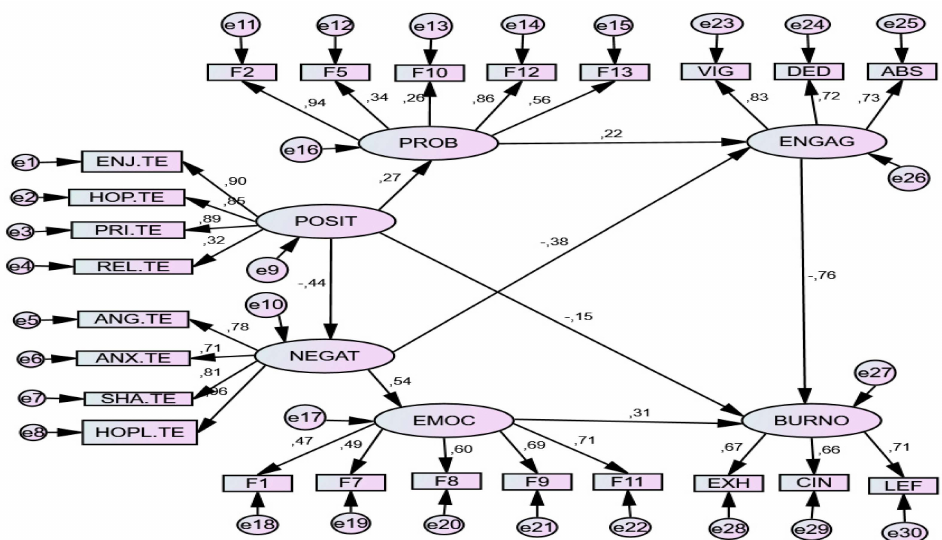
Figure 4. SEM model for Test Situation (Stress level 3) . Note . POSIT = Positive Achievement Emotions (Enjoyment, Hope, Pride); NEGAT = Negative Achievement Emotions (Anger, Anxiety, Shame, Hopelessness, Boredom); PROB. Problem-focused strategies : F2. Seeking help and family advice; F5. Self-Instructions; F10. Positive reappraisal and firmness; F12. Comunicating feelings and social support; F13. Seeking alternative reinforcement; EMOC = Emotion-focused strategies F1. Avoidant distraction; F7. Reducing anxiety and avoidance; F8. Preparing for the worst; F9. Emotional venting and isolation; F11. Resigned acceptance; ENGAG = Engagement (Vigor, Dedication, Absorption); BURNO = Burnout (Exhaustion, Cynicism, Lack of E ff ectiveness).